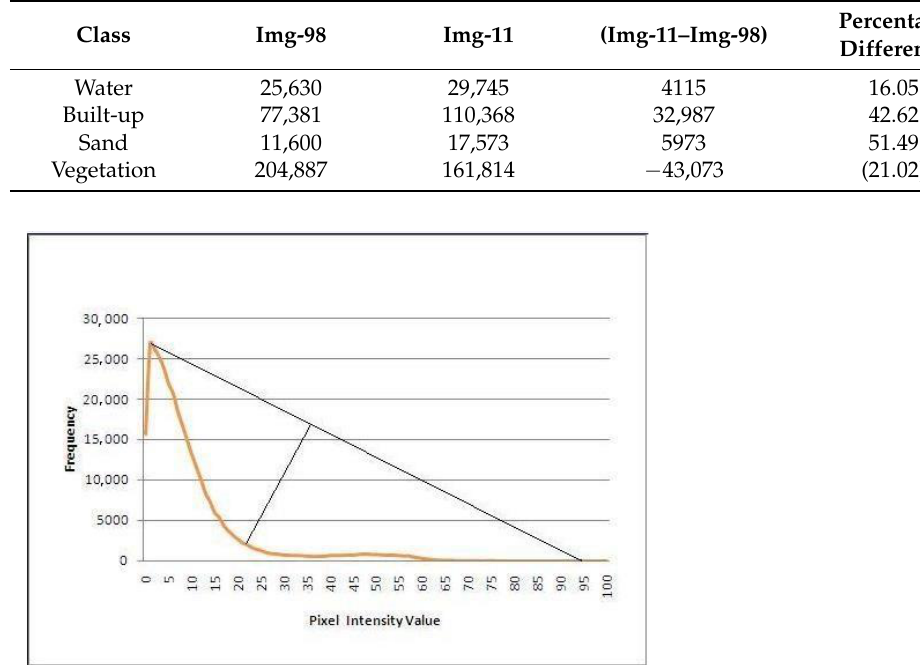
Figure 7. Histogram of corner method.